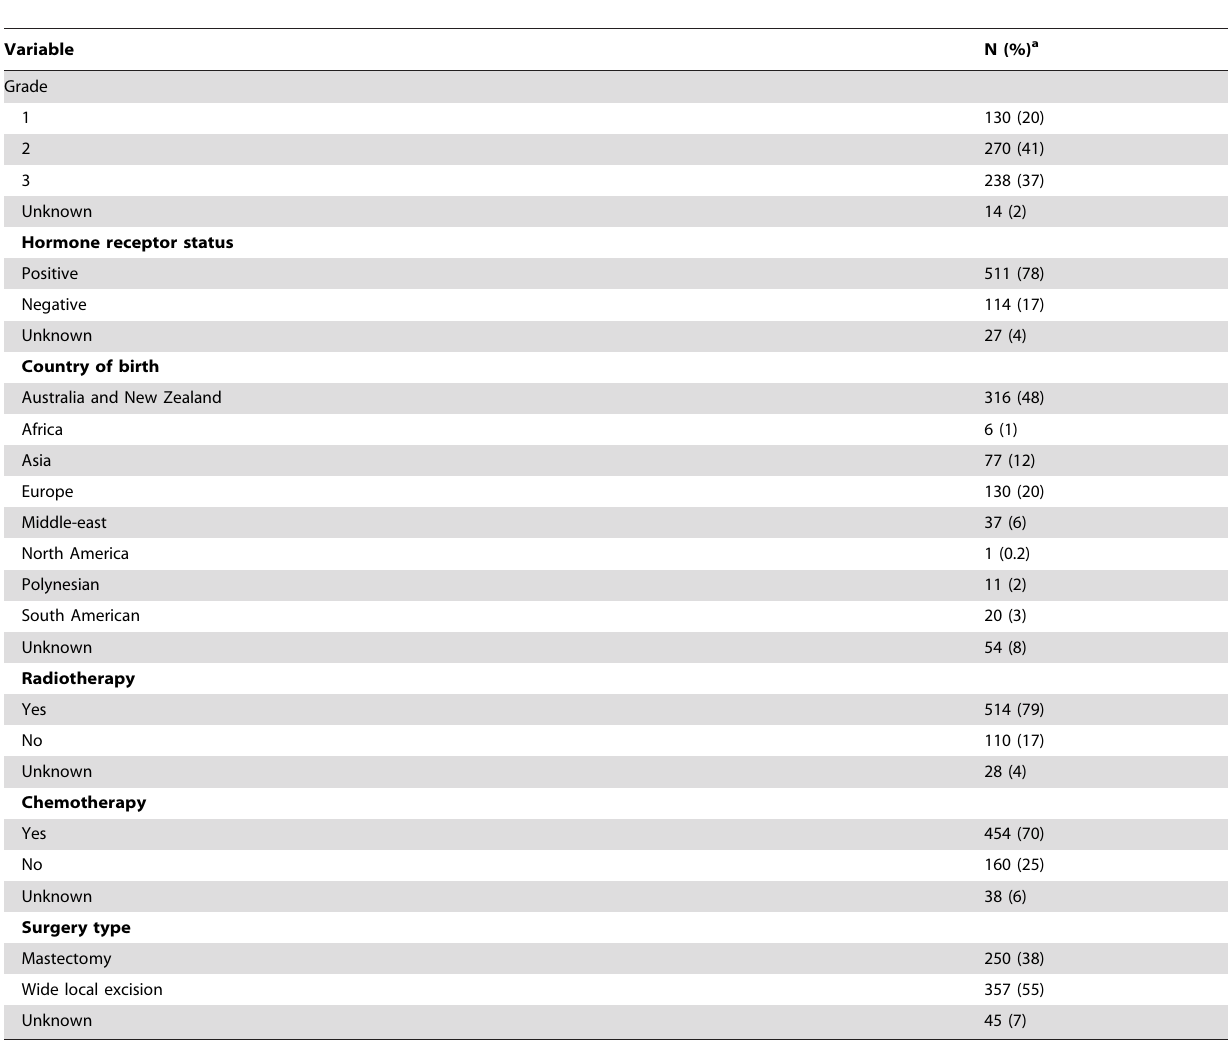
Table 1. Baseline patient